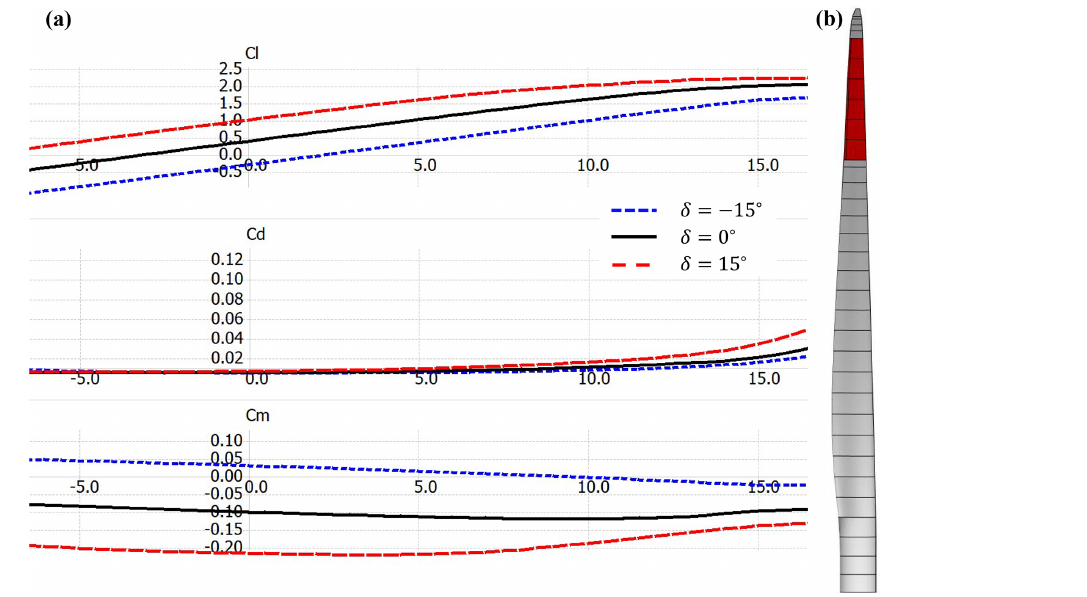
Figure 1. Trailing edge flaps on the DTU 10MW RWT blade. (a) FFA-W3-241 airfoil polars with different flap deflection angles. (b) Position of the six flaps on the